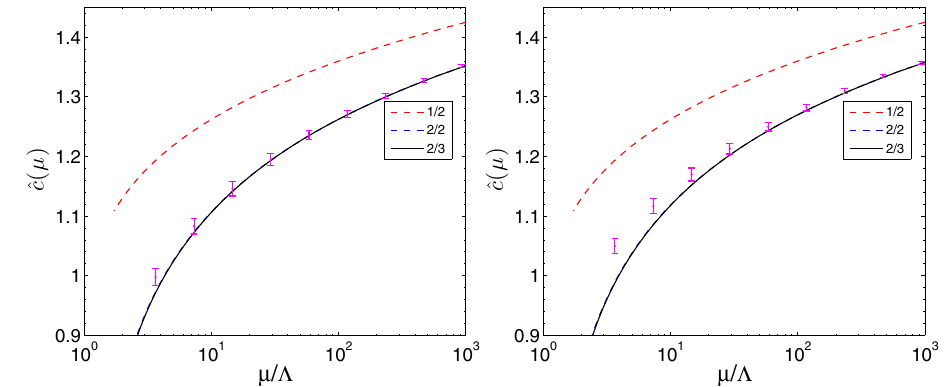
Fig. 10 Running of the tensor current for N f = 2 in the schemes α = 0 (left) and α = 1 / 2 (right), compared to perturbative predictions using the 1 / 2-, 2 / 2-, and 2 / 3-loop values for γ T /β